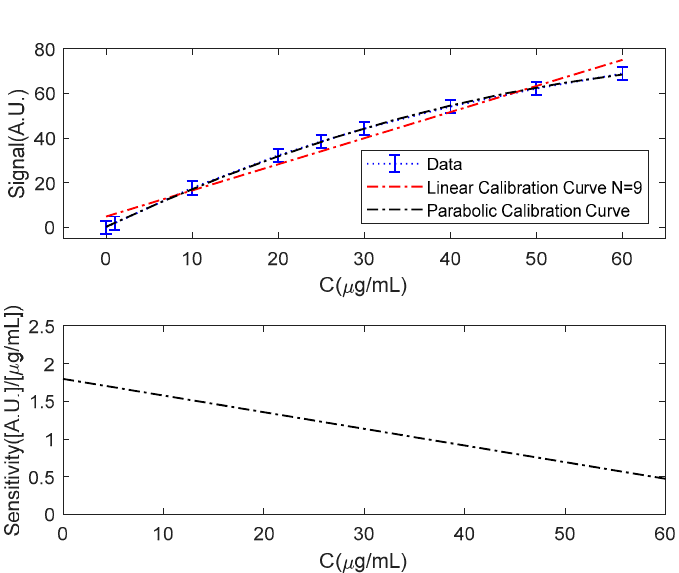
Figure 8. Data, calibration line N = 9 and parabolic fit and parabolic fit sensitivity.